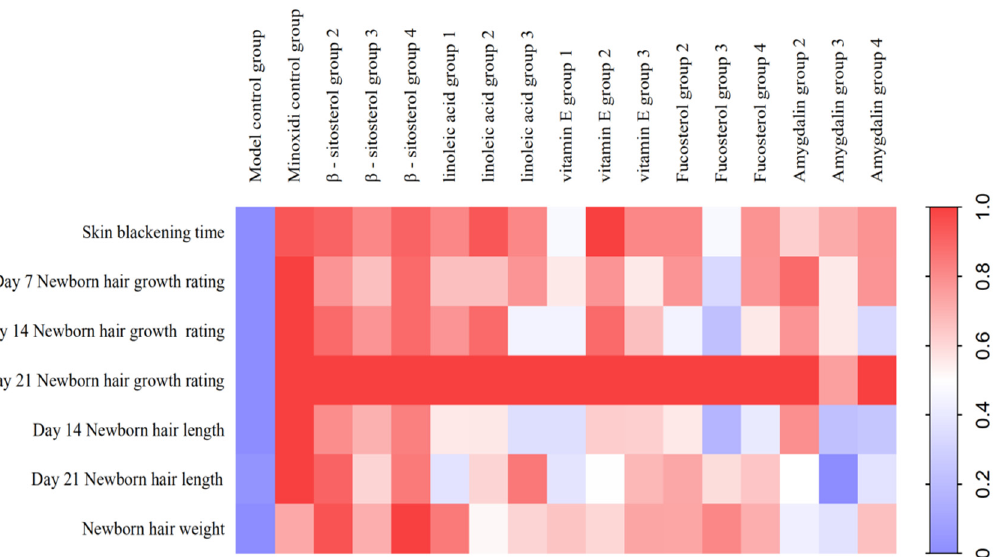
Figure 12. Heat map of the degree of influence of components of the kernel of P. mira on the depilation of C57BL/6 mice induced by sodium sulfide (note: the closer the color is too red, the more obvious the promoting effect of the test substance on hair growth).